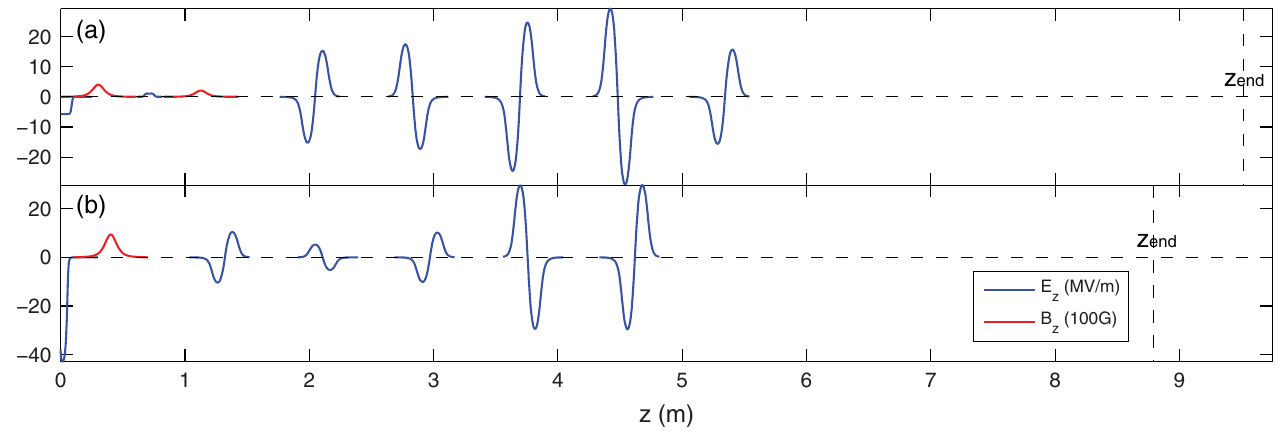
FIG. 5. Typical axial fields in the injector: (a) the dc and (b) the SRF gun based.